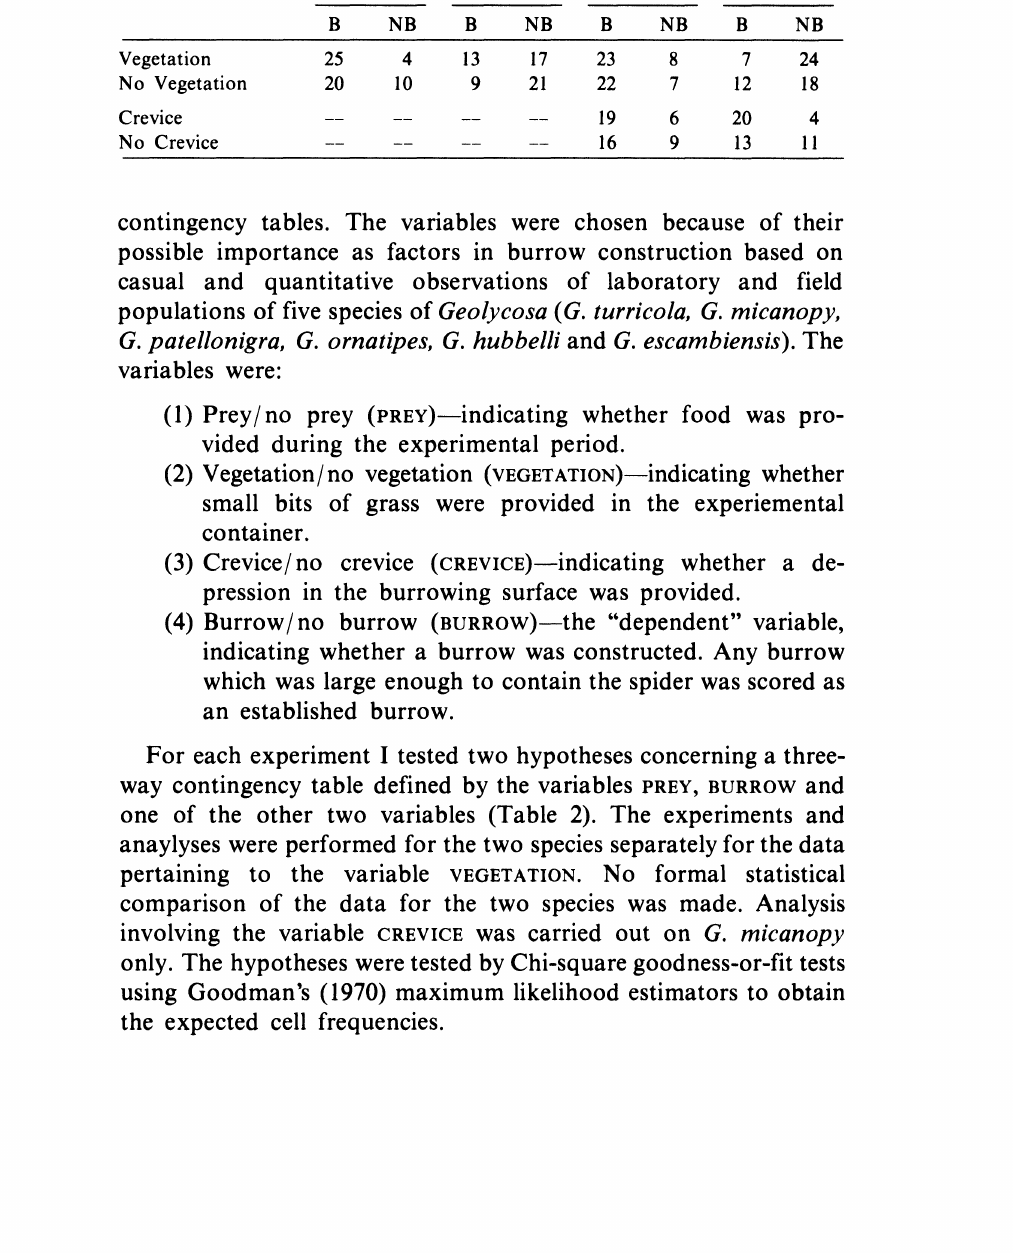
Table 1. Observed cell frequencies of burrow establishment for Geolycosa turri- cola and G. micanopy under experimental conditions. B burrow established, NB no burrow